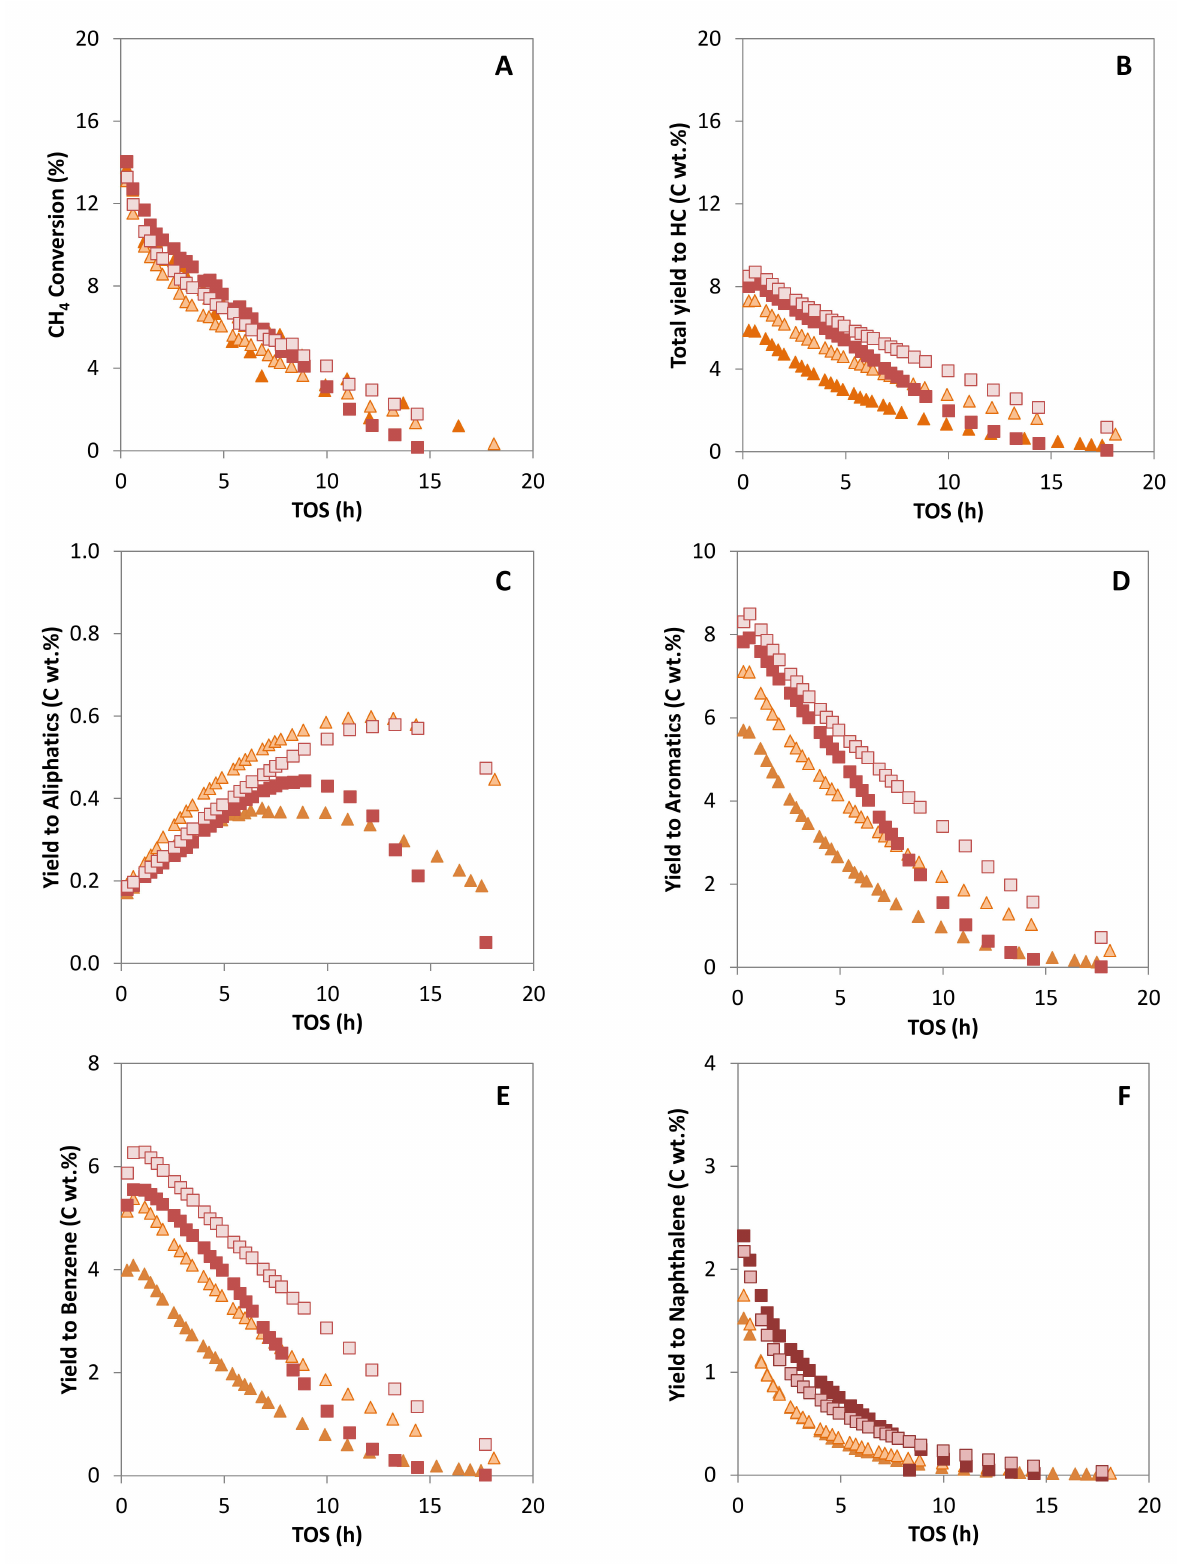
Figure 6. Methane conversion ( A ), total yield to hydrocarbons products ( B ), yield to aliphatics hydrocarbons ( C ), to aromatics hydrocarbons ( D ), to benzene ( E ) and to naphthalene ( F ) versus time on stream (TOS) for the catalysts: MoZ5- SSR-DC ( ), MoZ5-SSR-SC-N 2 ( ), MoZ5-SSR-DC ( ) and MoZ5-SSR-DC-N 2 ( ), at 973 K and atmospheric pressure (w/F = 16 g ·